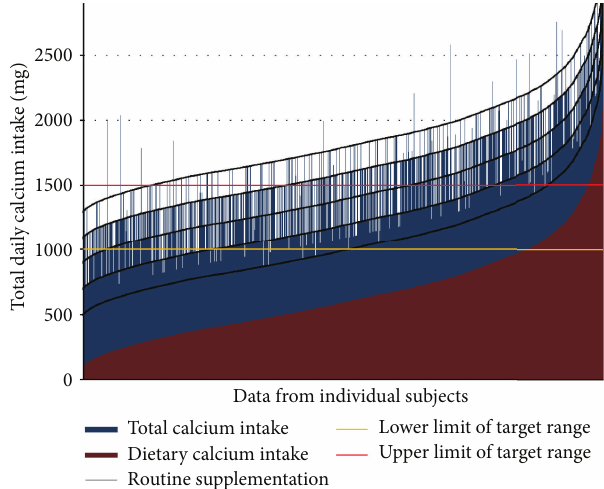
Figure3:Therelationshipbetweencalciumintakefromsupplemen- tation and from dietary sources. Note . The recommended RDA of 1000 to 1500 mg total calcium intake is met in approximately 34.5% ofpatientsonly.Inthemajorityofsubjects,totaldailycalciumintake is either below or above the recommended